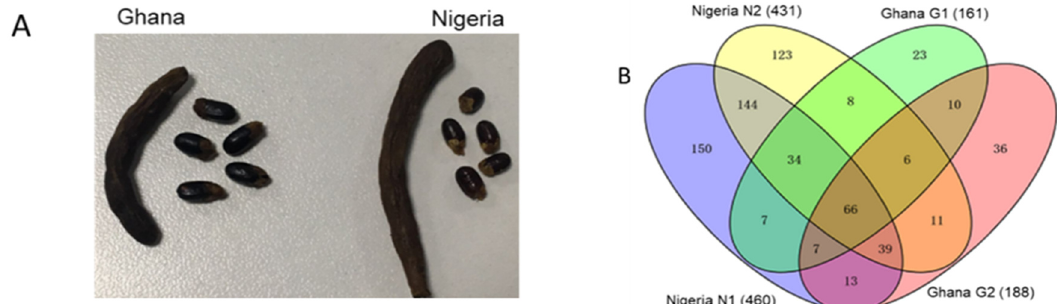
Figure 1. ( A ). Pictorial presentation of the phenotypic characteristics of Xylopia aethiopica fruits and seeds from Ghana and Nigeria. ( B ). Venn diagram presentation of protein distribution including common proteins identified in the seeds of X. aethiopica from Nigeria and Ghana. Proteins extracted from seeds were digested, analyzed using nano-LC-MS/MS, and identified based on protein ID number.